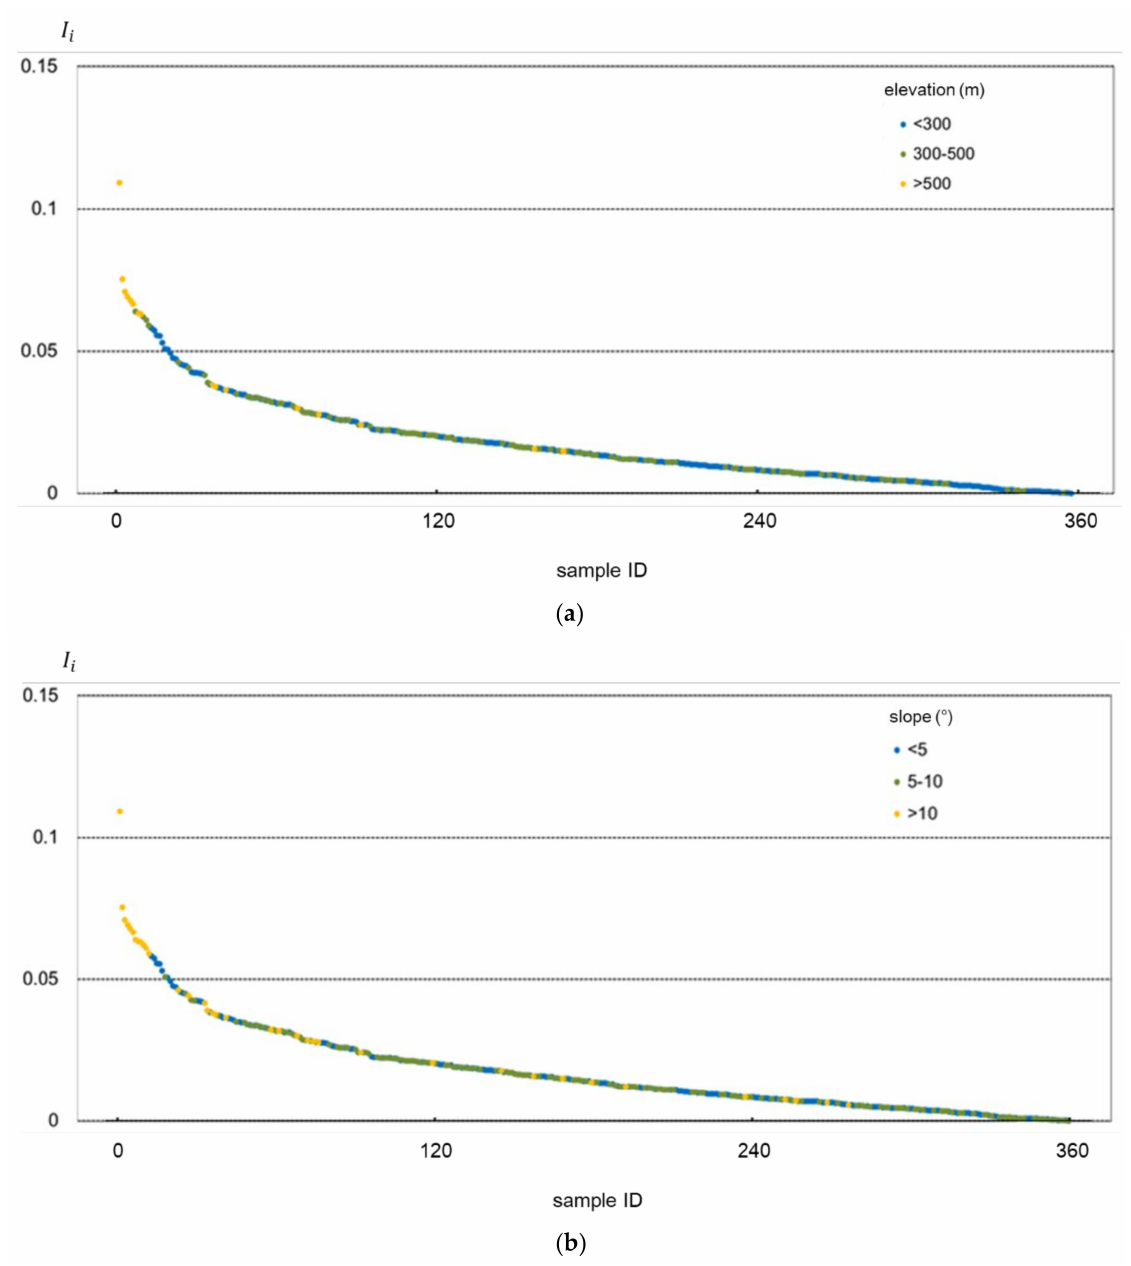
Figure 8. The accuracy improvement of samples by adding slope as the input parameter. In ( a ), the samples are categorized into three groups by elevation and ( b ) by the